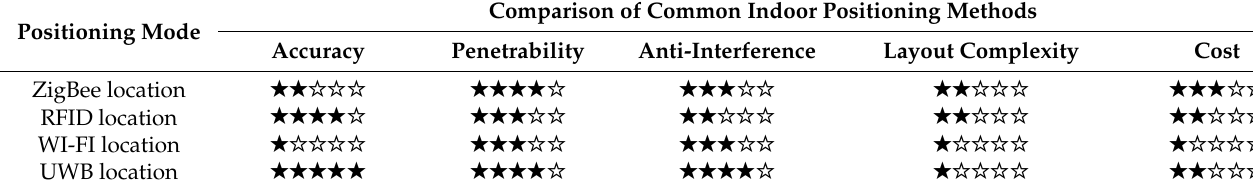
Table 1. Common indoor positioning methods.